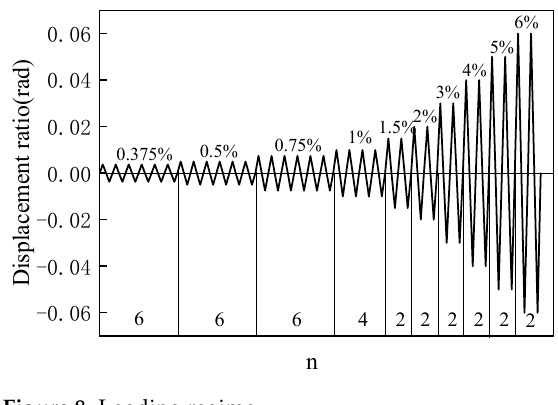
Figure 8. Loading regime.